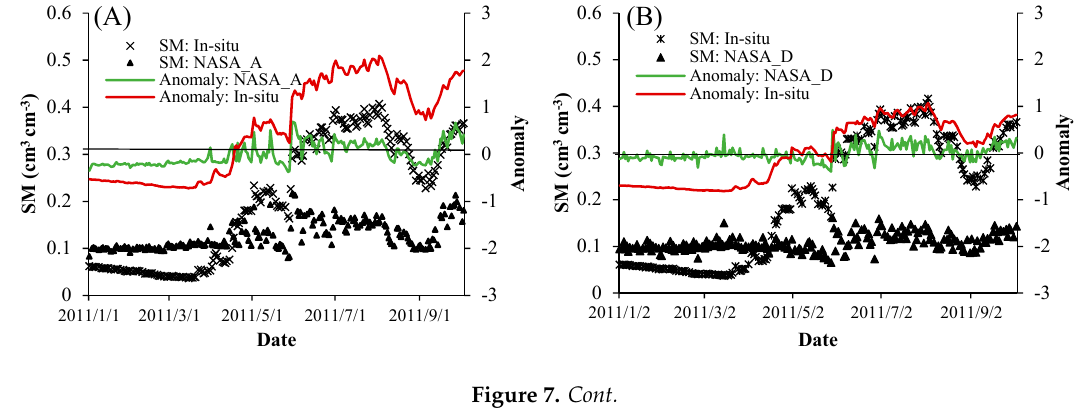
Figure 6. Comparison of AMSR-E/NASA or JAXA SM products with in-situ SM measurements data in 2011: ( a ) AMSR-E/NASA during ascending orbits and ( b ) descending orbits; ( c ) AMSR-E/JAXA during ascending orbits, and ( d ) descending